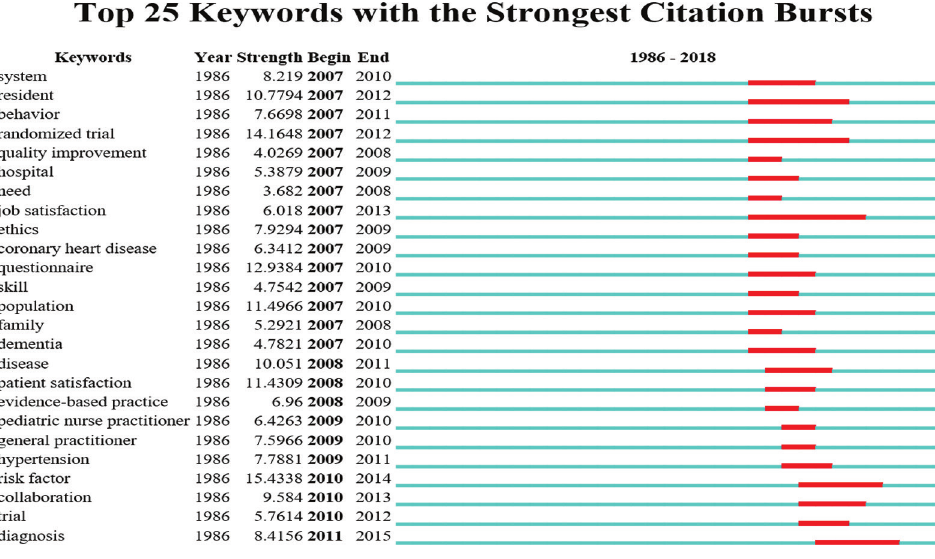
Figure 6. Keywords with the strongest citation burst.